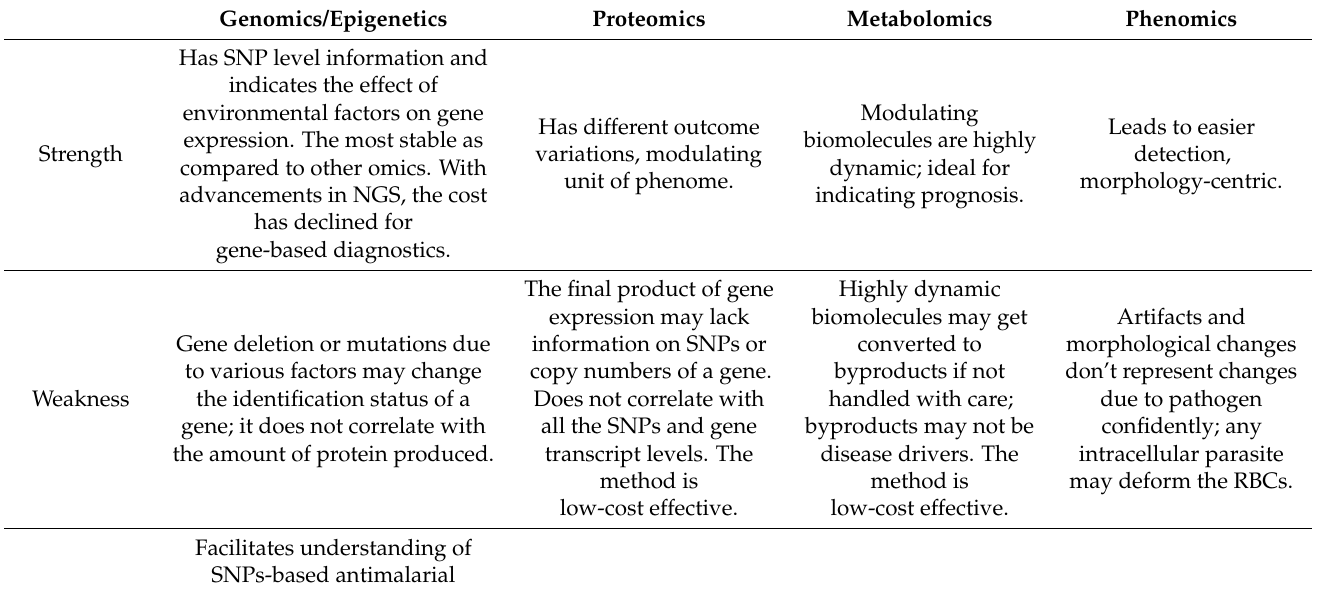
Table 3. SWOT analysis of omics-based malaria diagnostic